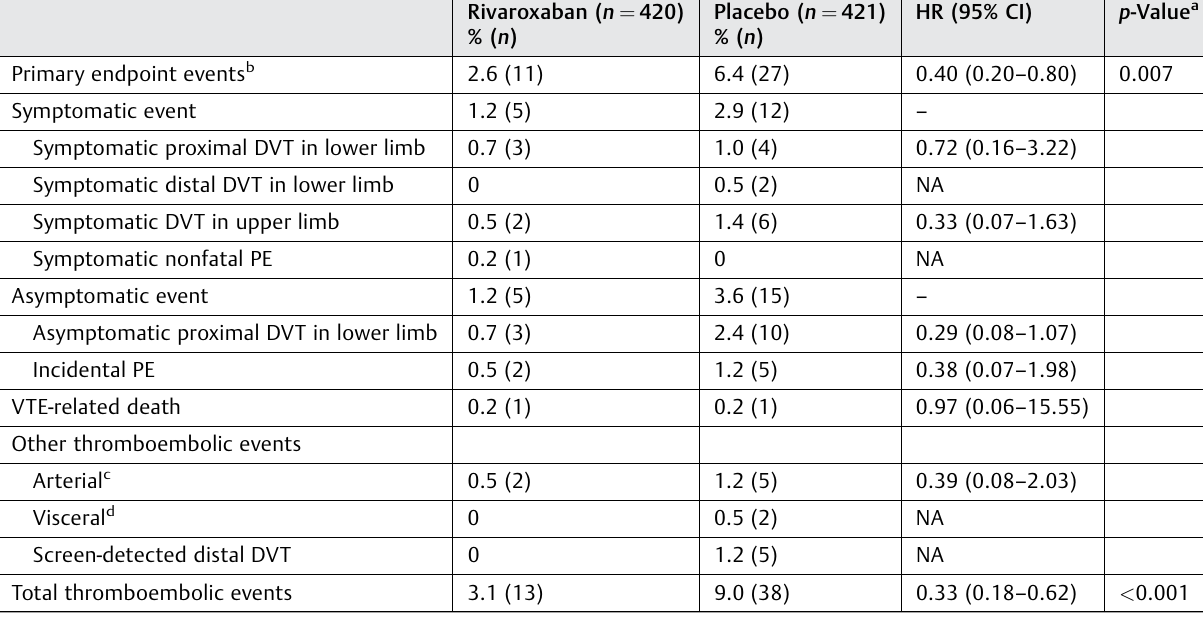
Table 2 Primary and secondary thromboembolic endpoint events during the intervention period, according to study group